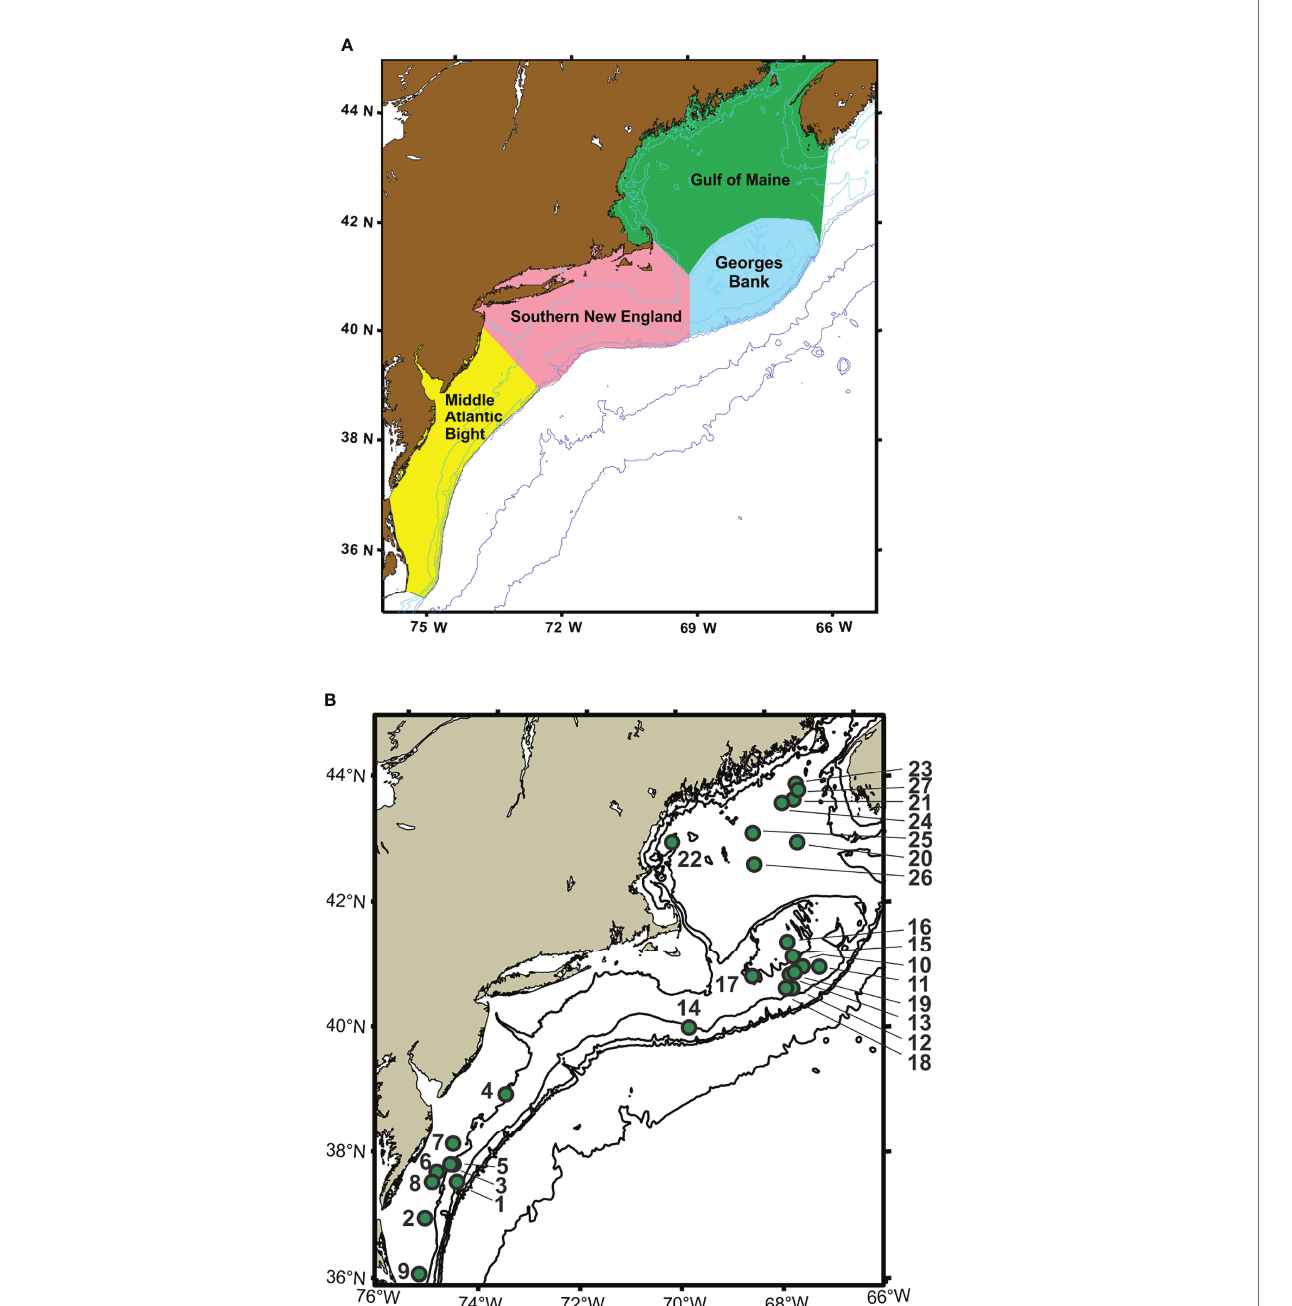
FIGURE 1 | Maps showing regions (A) and sample collection locations (B) for Northeast Fisheries Science Center (NEFSC) Ecosystem Monitoring Surveys (EcoMon). Stations are identi fi ed by number (see Table 1 ). Modi fi ed from Bucklin et al.